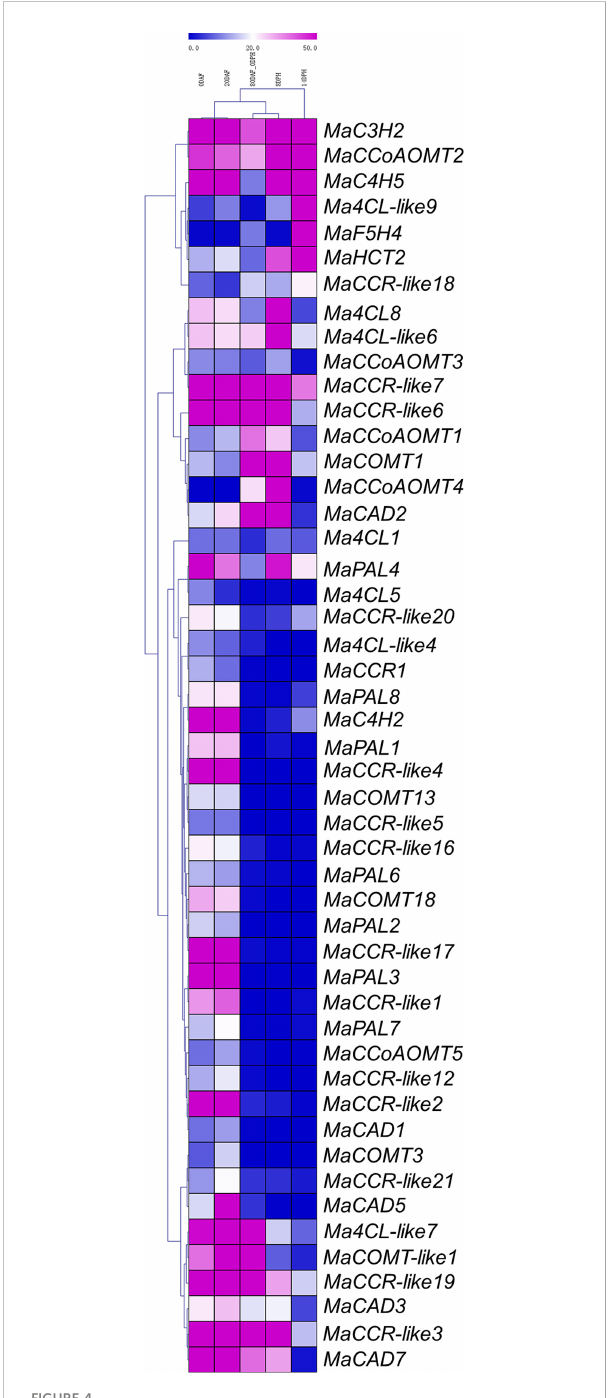
FIGURE 4 Expression patterns of lignin biosynthesis genes in different stages of fruit development and ripening. The heatmap with dendrogram was created based on the RPKM value of the lignin biosynthesis genes. Differences in gene expression changes were shown in color as the